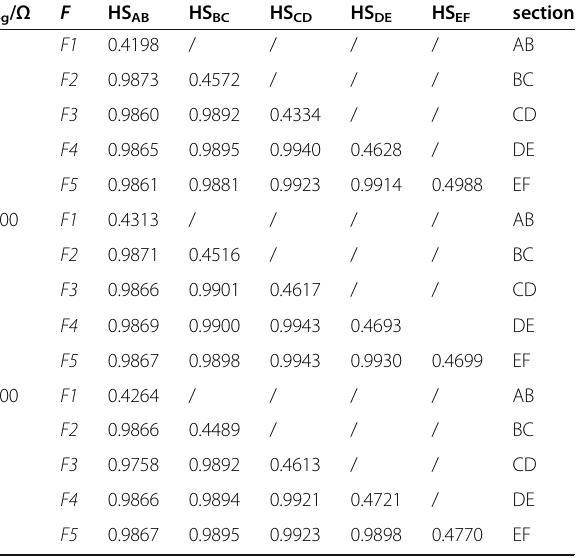
Table 8 Results of the proposed positioning method ( φ = 60 ∘ ,